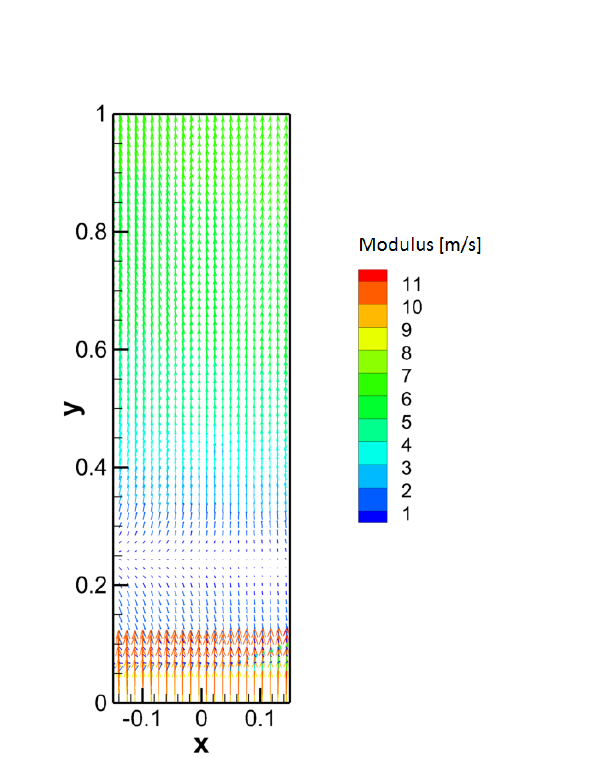
Fig. 3. Mean velocity vectors distribution